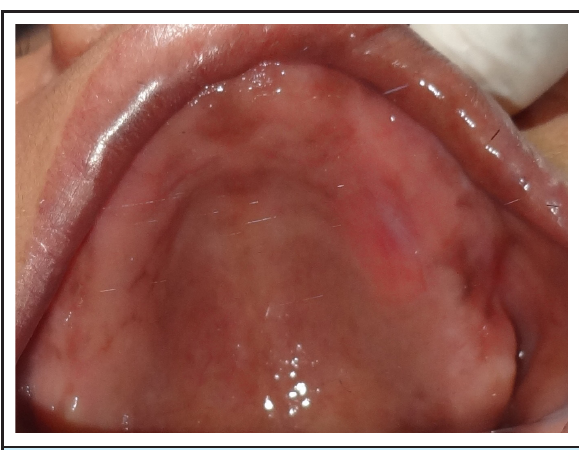
Figure 6. Postoperative view after 1 month with excellent healing.